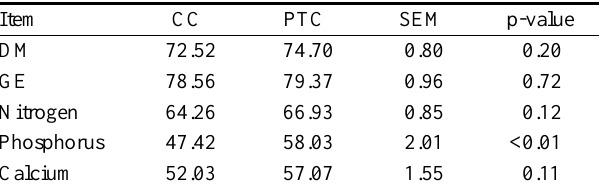
Table 5. Effect of conventional corn (CC) or phytase transgenic corn (PTC) in the diet on the apparent ileal nutrients digestibility (%) of laying